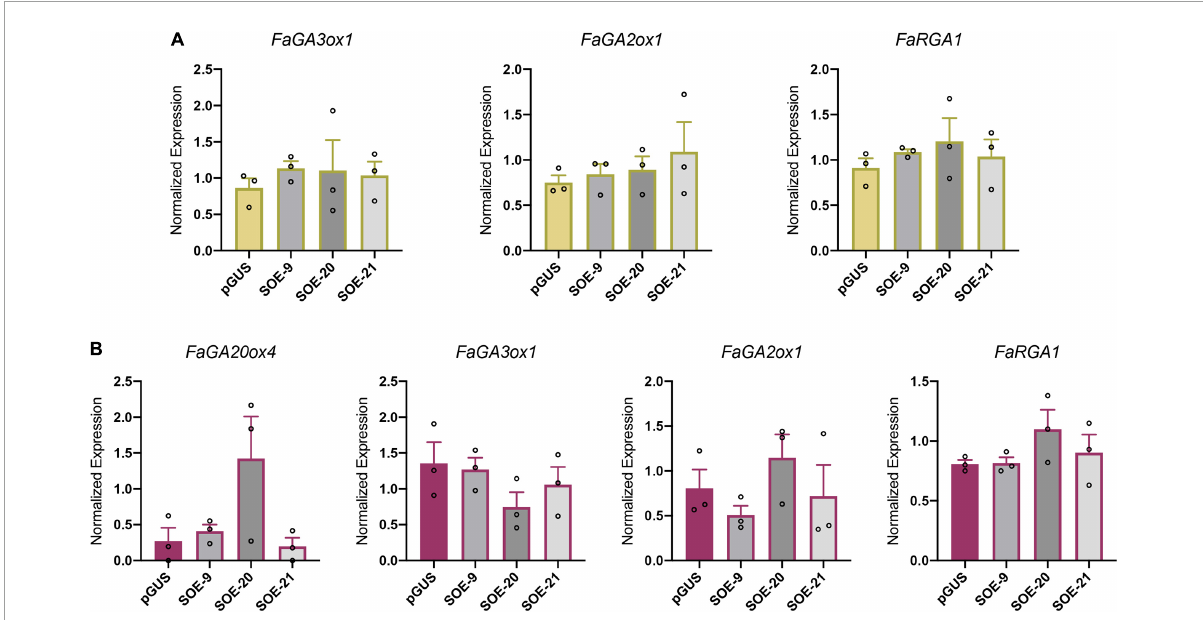
FIGURE6 Overexpression of FaSOC1 does not alter the expression of GA metabolism and signaling related genes. (A) FaGA3ox1 , FaGA2ox1 , and FaRGA1 expression in leaves of three independent SOE lines. (B) FaGA20ox4 , FaGA3ox1, FaGA2ox1 , and FaRGA1 expression in crowns from SOE lines. All samples were collected under SD. Graphs show the average of normalized values from three biological replicates ± SEM. In each bar, dots represent the normalized value of each biological